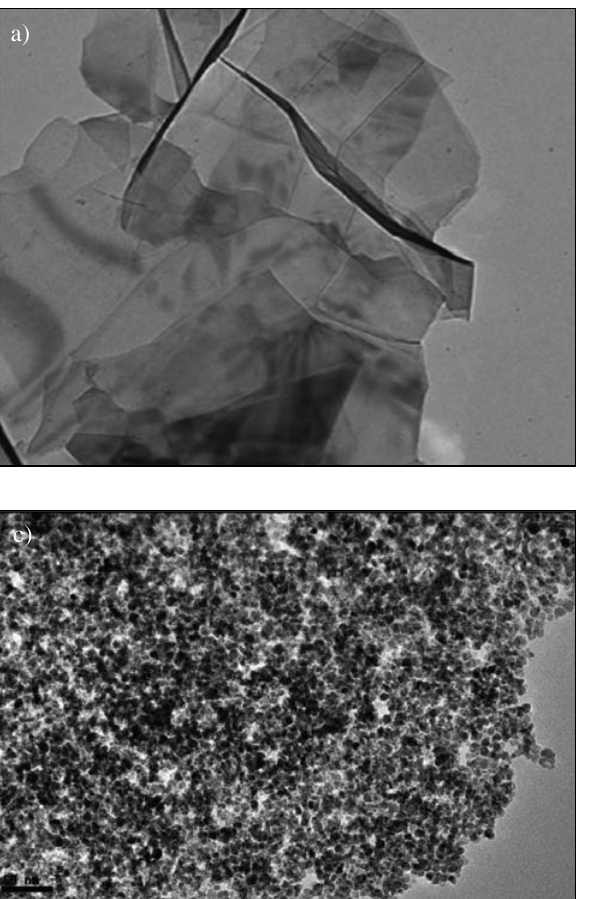
Figure 3. TEM images of (a) GO, (b) NG, (c) NiFe